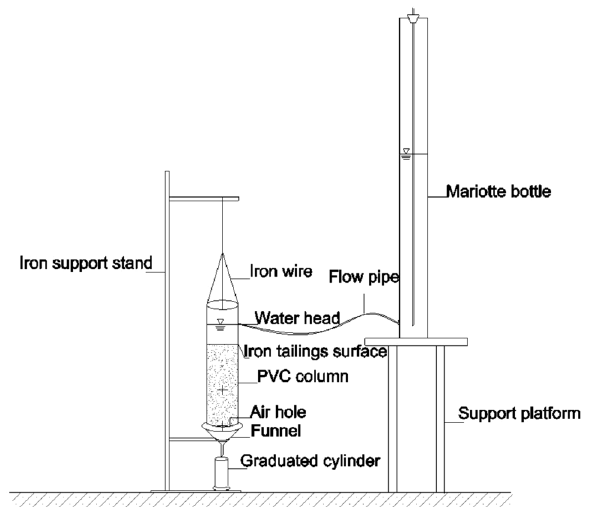
Figure 9. Schematic diagram of experimental setup of saturated hydraulic